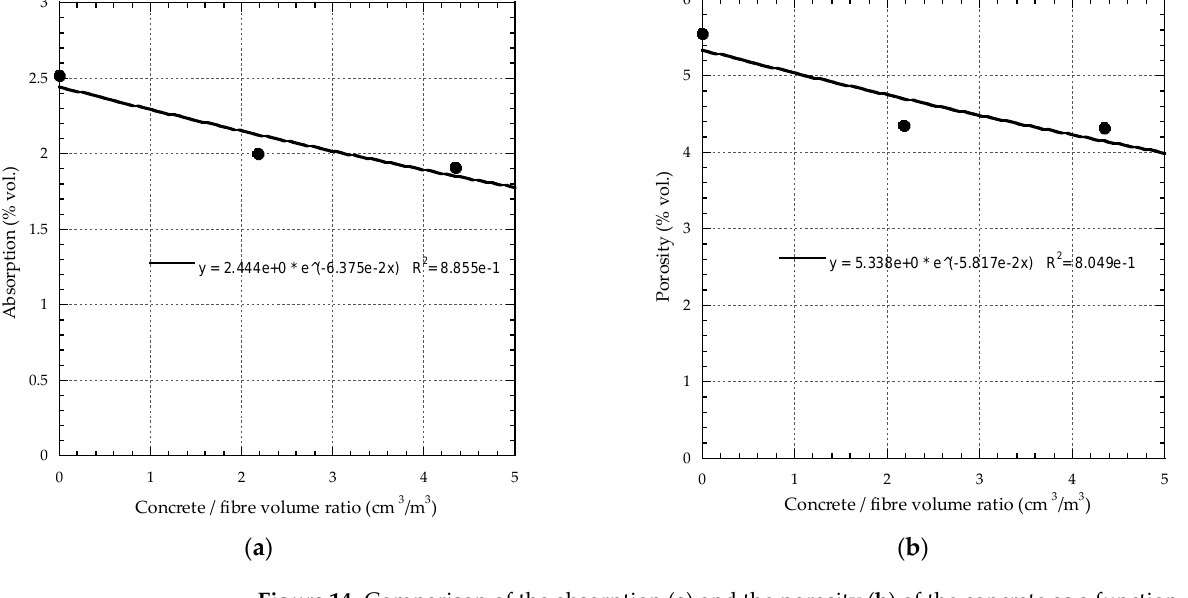
Figure 14. Comparison of the absorption ( a ) and the porosity ( b ) of the concrete as a function of the concrete/fibre volume ratio.